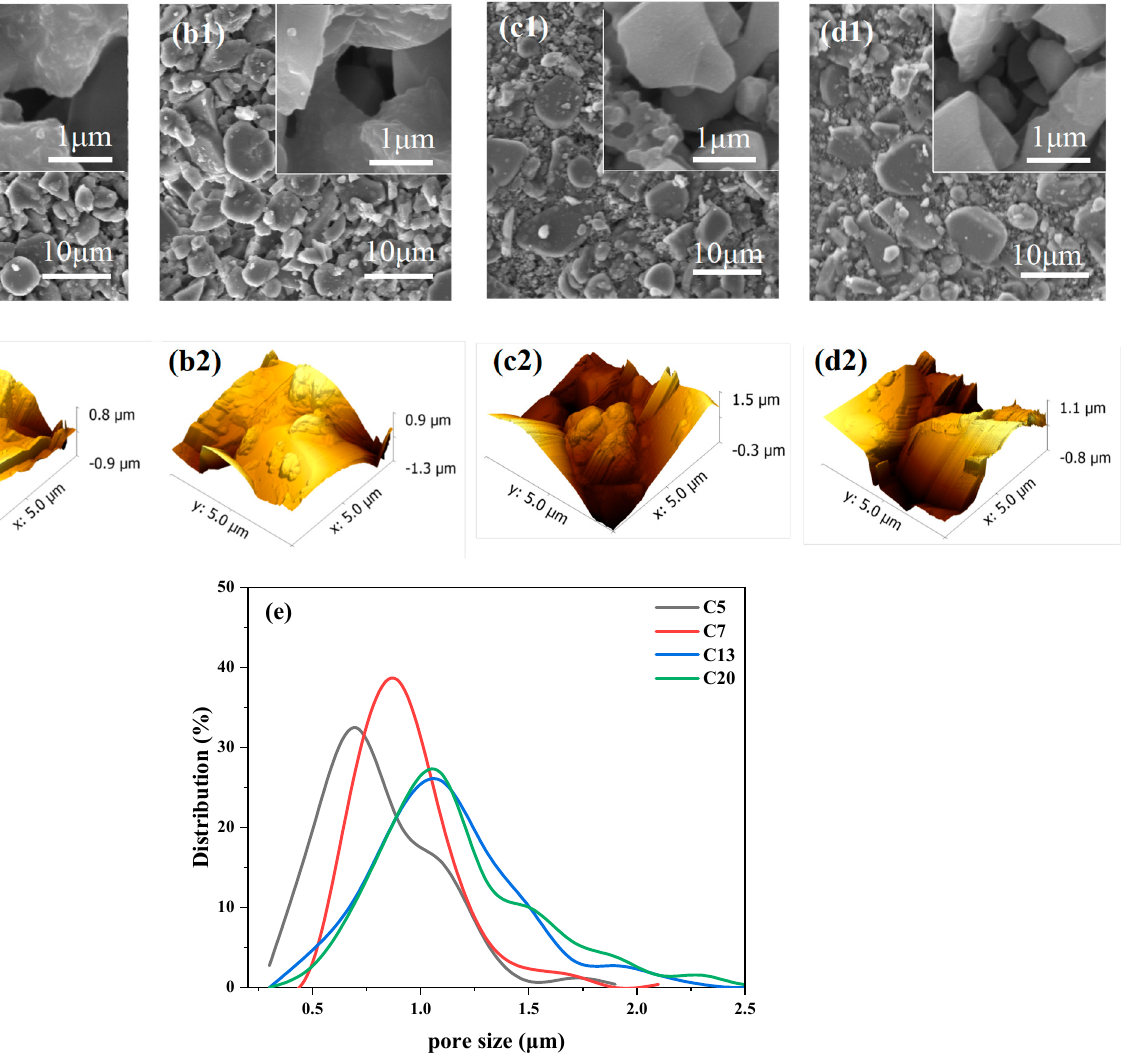
Figure 4. SEM and AFM images of different membranes: ( a1 – d2 ) C5, C7, C13, C20; ( e ) pore size distribution of different membranes.